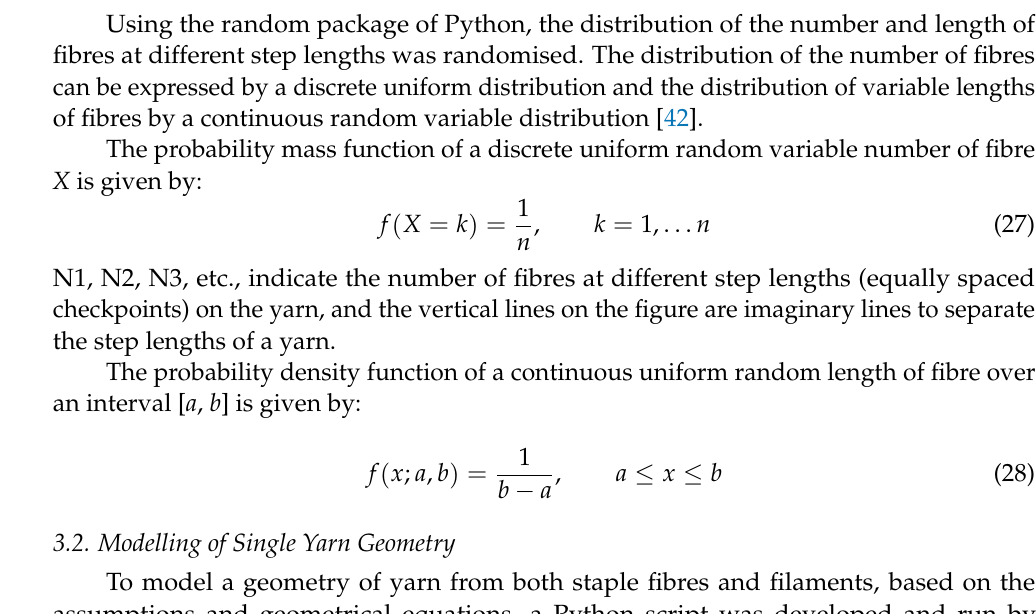
Figure 9. Distribution of staple fibres on